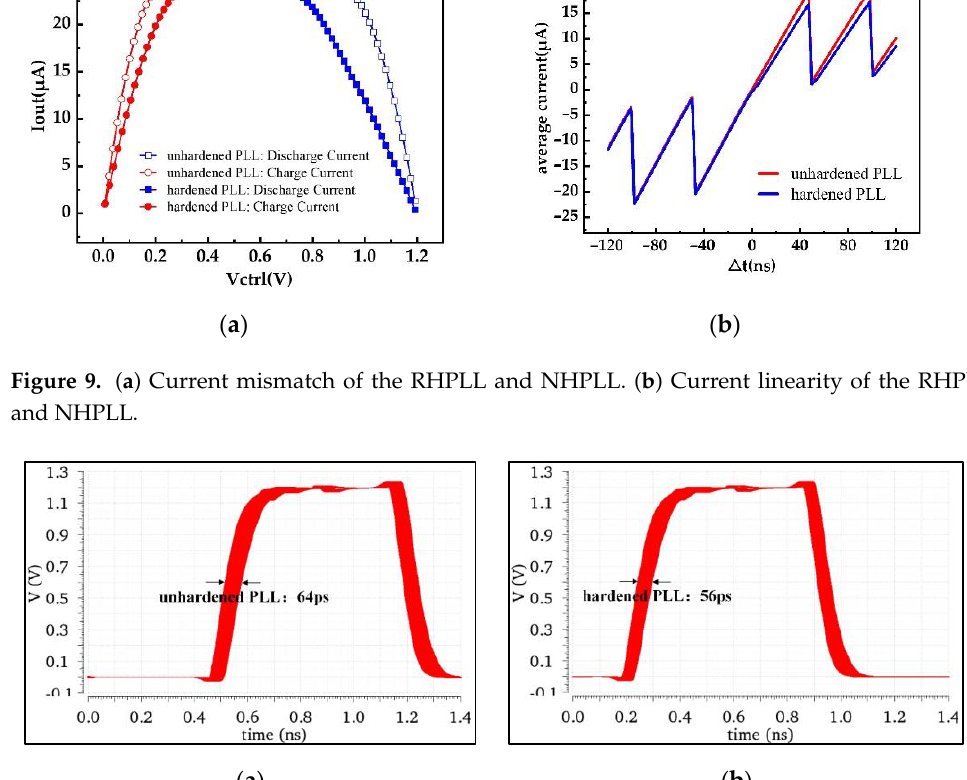
Figure 9. ( a ) Current mismatch of the RHPLL and NHPLL. ( b ) Current linearity of the RHPLL and NHPLL.